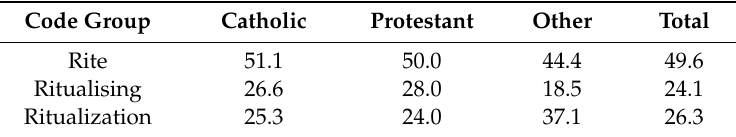
Table 6. Dimensions of prayer—personal context—church a ffi liation. Code Group Catholic